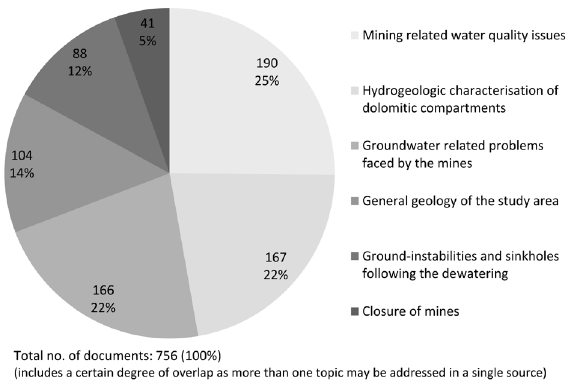
Number (%) of documents per category considered in this review, ranked in descending